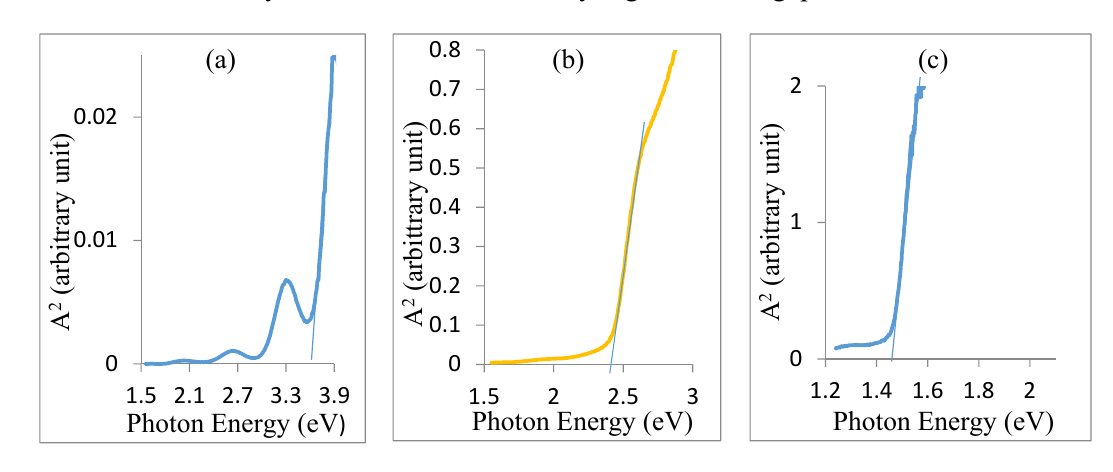
Figure 2. Square of absorbance (A 2 ) vs. photon energy for annealed layers of ( a ) ZnS, ( b ) CdS and ( c )